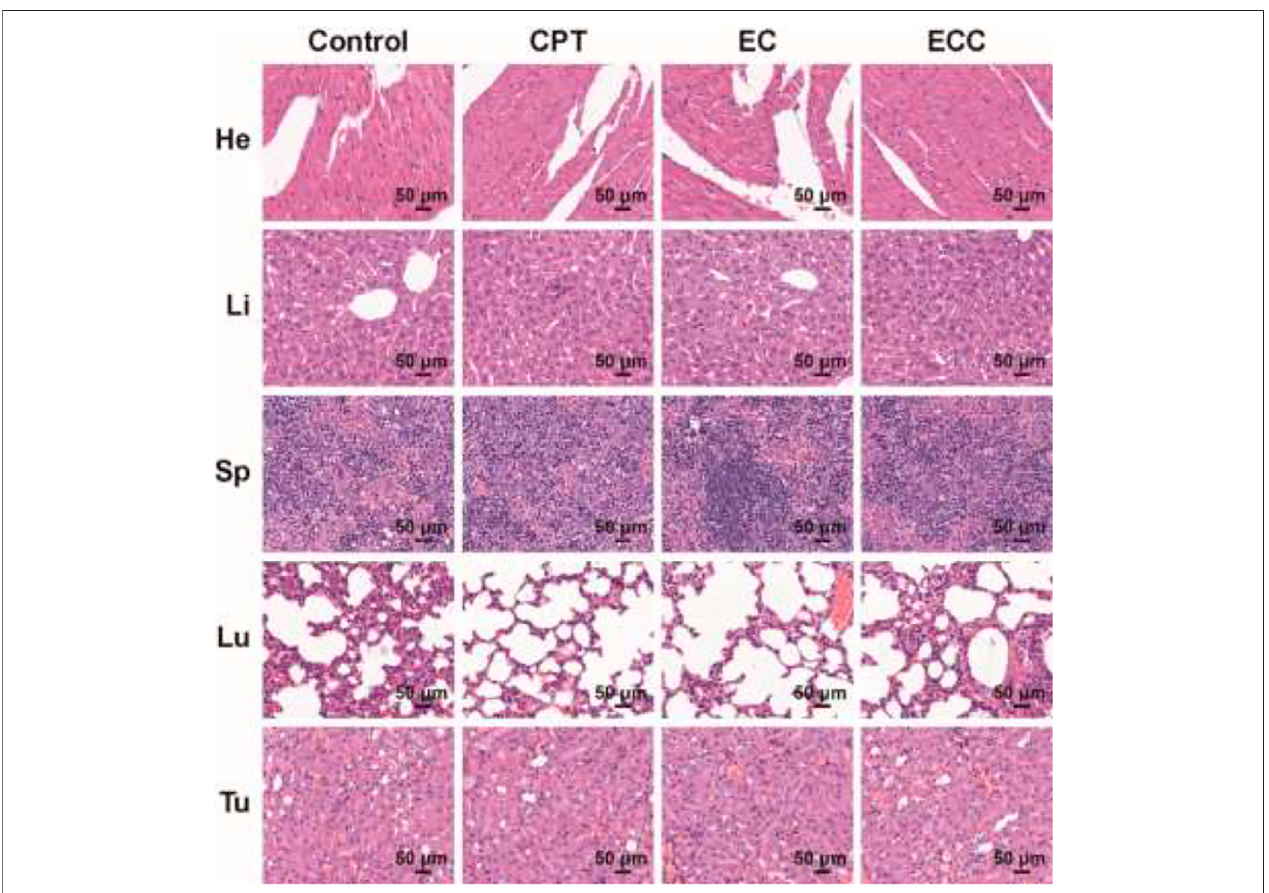
FIGURE 5 | H&E staining of tumor samples from mice injected with PBS, CPT, ECC, and EC.